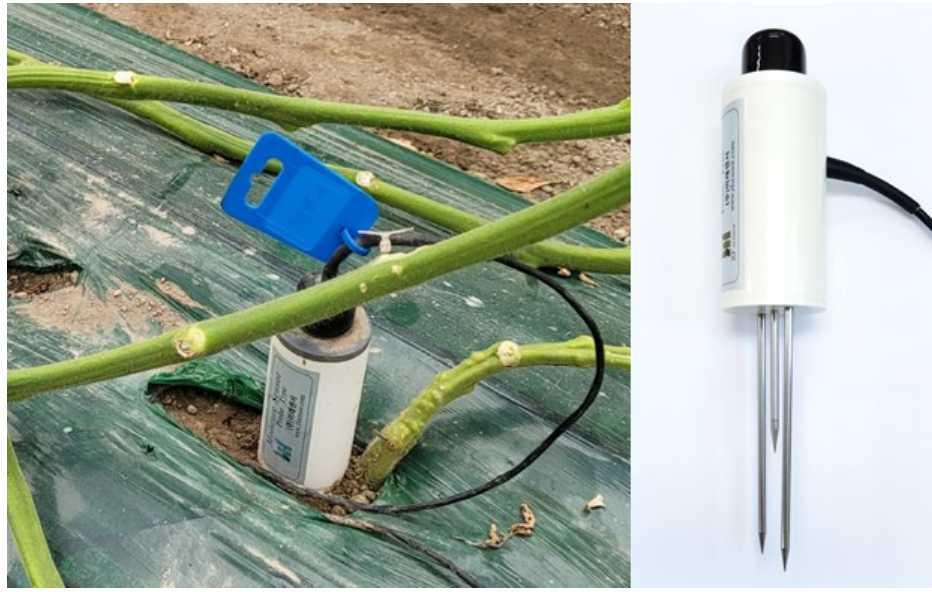
Figure 3. The photos of the FDR sensor. Table 1. The specification of the FDR sensor.